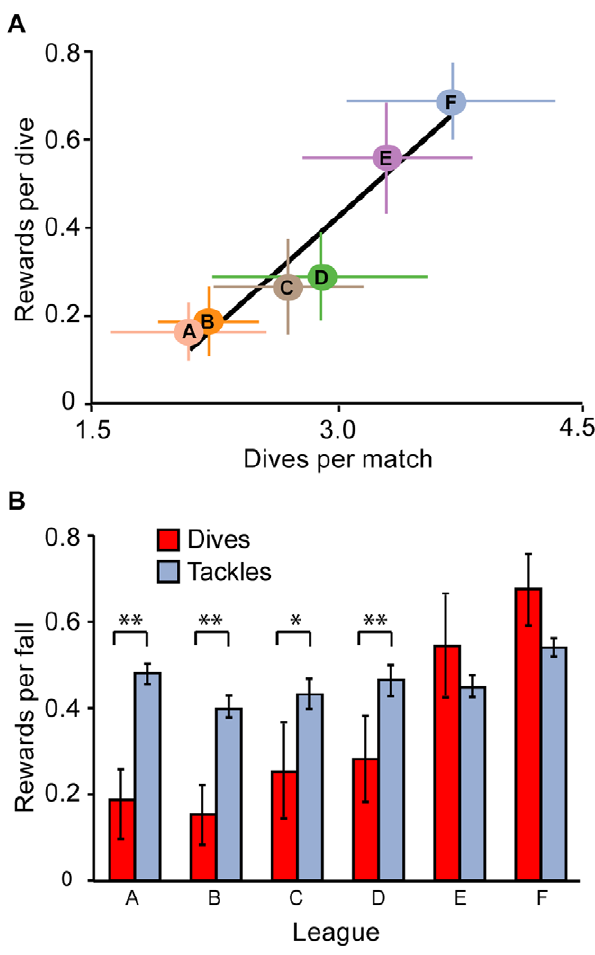
Figure 2. Detection of deception across leagues. (A) The mean proportion of total dives that were rewarded by the referee with a free- kick and the mean dive frequency of 10 matches in each league ( n =6). (B) Separated in to dives or tackles, the mean proportion that were rewarded by the referee across matches ( n =10) within each league. Leagues (A – F) are not identified due to ethical considerations. Standard error bars are presented. Black solid line indicates R 2 however Spearman’s rank correlation coefficient, rho , was used to calculate significance. Asterisks denote significant differences based on Paired- Wilcoxen signed rank tests ( P , 0.05; ** P , 0.01; *** P , 0.001).